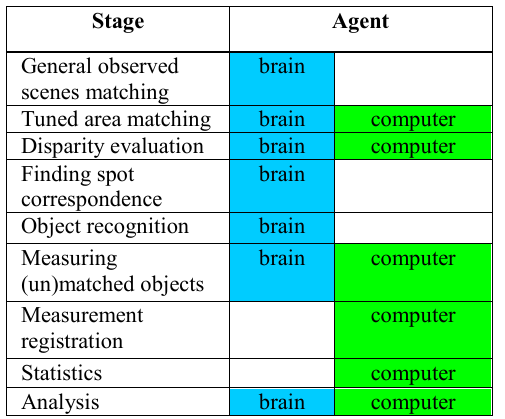
Table 1. Strengths of humans and computers in geospatial image analysis (Gienko and Levin, 2007)